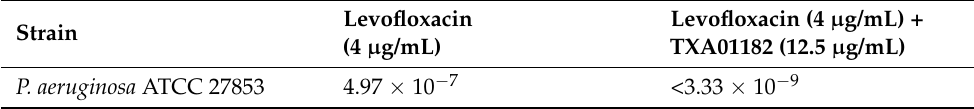
Table 4. Frequency of resistance to TXA09155 and